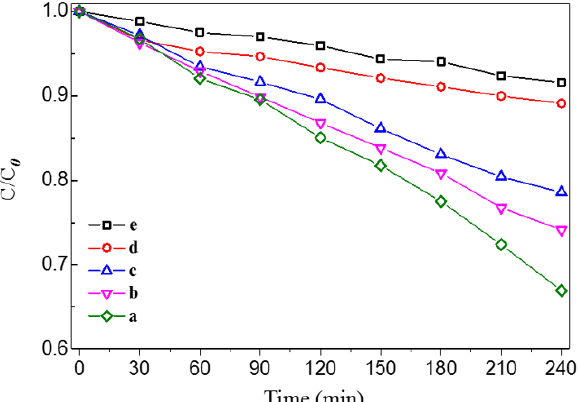
Figure 9. Intervention of ROS scavengers during SMT degradation by ZnO / Cu x = 1.25 O %) under simulated solar light on the following: ( a ) 0.01 mM NaN 3 , ( b ) no scavenger, ( c ) 0.5 mM p-benzoquinone, ( d ) 0.5 mM methanol, and ( e ) 0.5 mM EDTA-2Na. The light intensity under visible light irradiation was 50.1 mW / cm 2 .